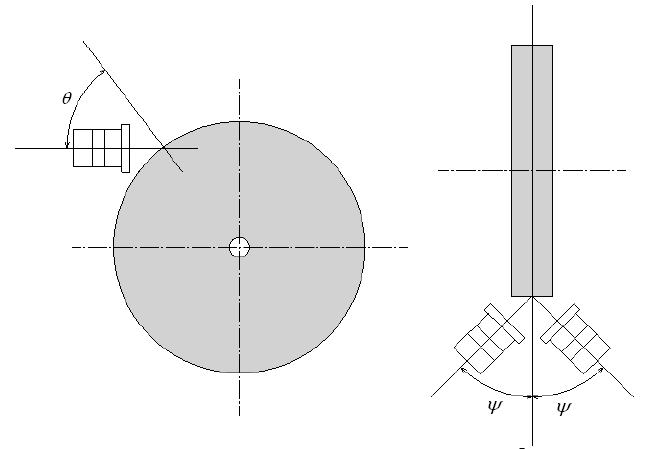
Figura 8: Configurazione per il rilievo di difetti superficiali con ispezione continua lungo la circonferenza del disco. Figure 8: Setup to detect surface defects with continuous inspection along the circumference of the